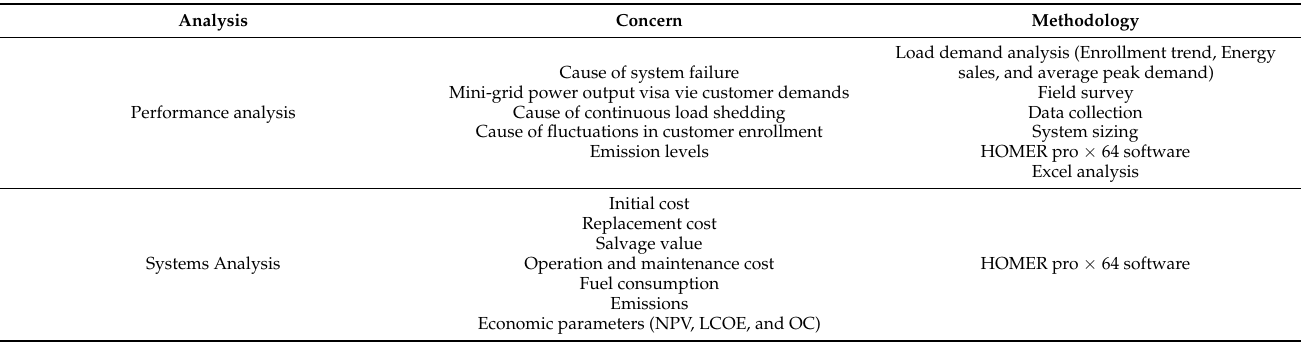
Table 2. Research concerns and methodology